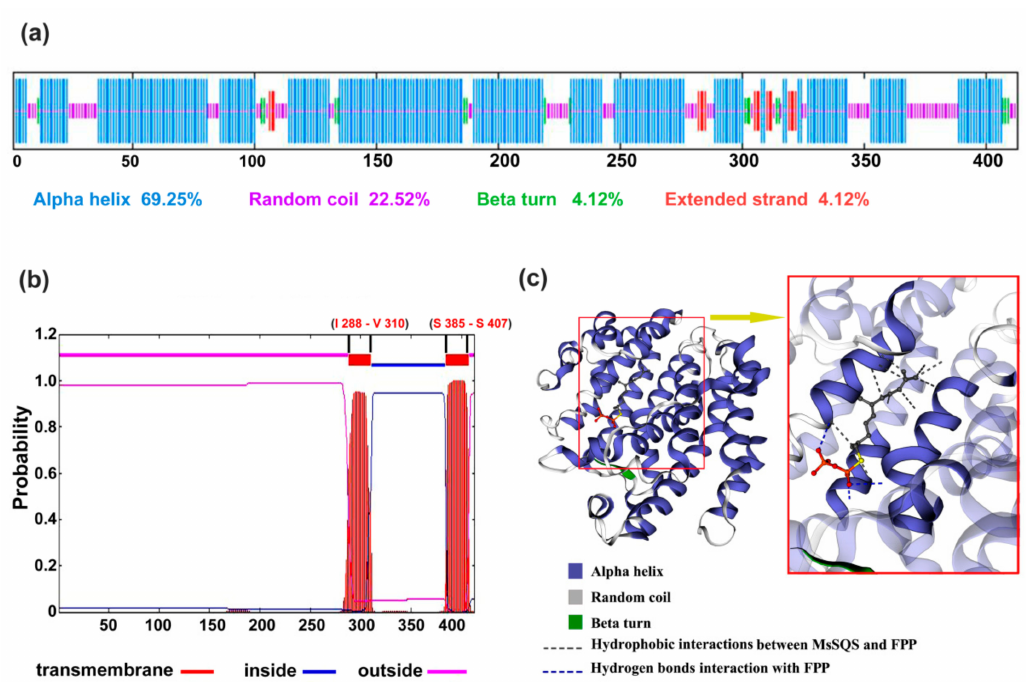
Figure 3. Analysis of the secondary structure and predicted 3-D model of MsSQS. ( a ) Annotation of the secondary structure of MsSQS using SOPMA online server (https: // npsa-prabi.ibcp.fr / cgi-bin / npsa_ automat.pl?page = npsa_sopma.html). Components of the secondary structure were listed in color corresponding to the individual structure. ( b ) The predicted transmembrane regions of MsSQS using TMHMM Server (v. 2.0) (http: // www.cbs.dtu.dk / services / TMHMM / ). ( c ) The homology-based 3-D structure of MsSQS generated with SWISS-MODEL (left panel). The center channel (boxed in red) of MsSQS was enlarged showing the interaction with farnesyl diphosphate (FPP) (right panel). 2.3. The MsSQS-GFP Recombinant Protein Resided Transiently on the Plasma Membrane of Onion Epidermal